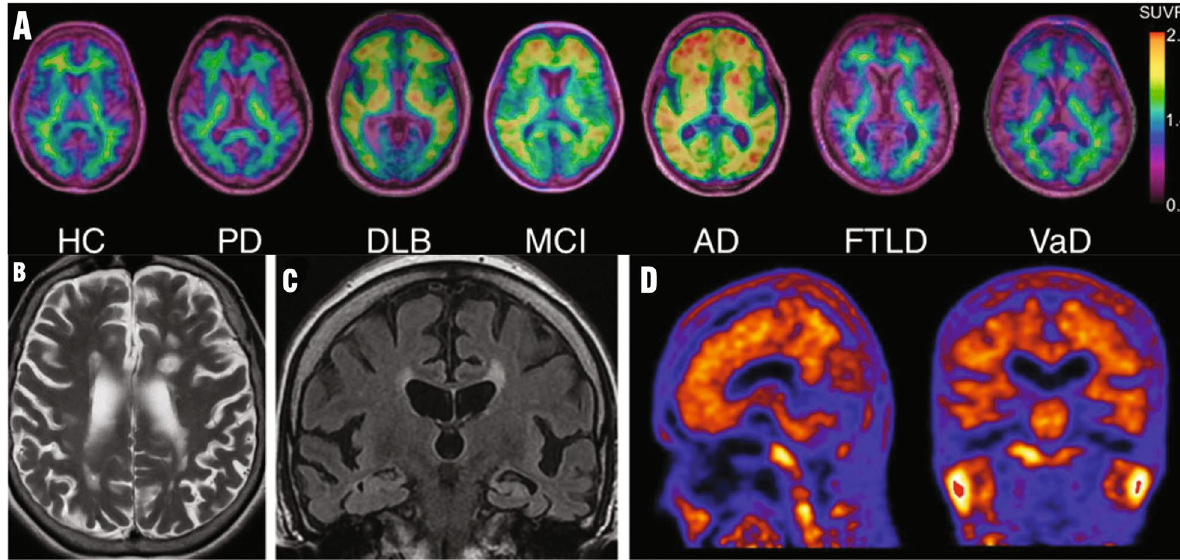
Fig. 2 A 18F-florbetaben PET transaxial images of healthy control (HC), patients with Parkinson’s disease (PD), dementia with Lewy bodies (DLB), mild cognitive impairment (MCI), Alzheimer’s disease (AD), frontotemporal lobar degeneration (FTLD), and vascular dementia (VaD). AD patients show cortical 18F-florbetaben uptake and non-specific white matter uptake visible in negative scans of HC, PD, FTLD, and VaD. All images are scaled to the same SUVR maximum. This research was initially published in JNM. Villemagne et al. B, 2011 [58]. B She has a family history of dementia in her sister’s late 60s. Difficulty completing the MMSE. She had been diagnosed with MS, and MRI imaging had been consistent with demyelination Brain MRI showed several inflammatory demyelinating lesions. API was positive. Axial T2-weighted C Coronal FLAIR images through the brain showing typical MS lesions in the periventricular white matter perpendicular to the ependymal surface. Note generalized neuroparenchyma loss, with relative sparing of the temporal lobe white matter (left mesial temporal atrophy score is 2; correct mesial temporal atrophy score is 1). D Sagittal and coronal amyloid PET images demonstrating generalized increased activity within the cortical gray matter in all lobes with complete loss of gray-white differentiation consistent with widespread amyloid deposition. This research was initially published in J. Neurol. M Kolanko et al.